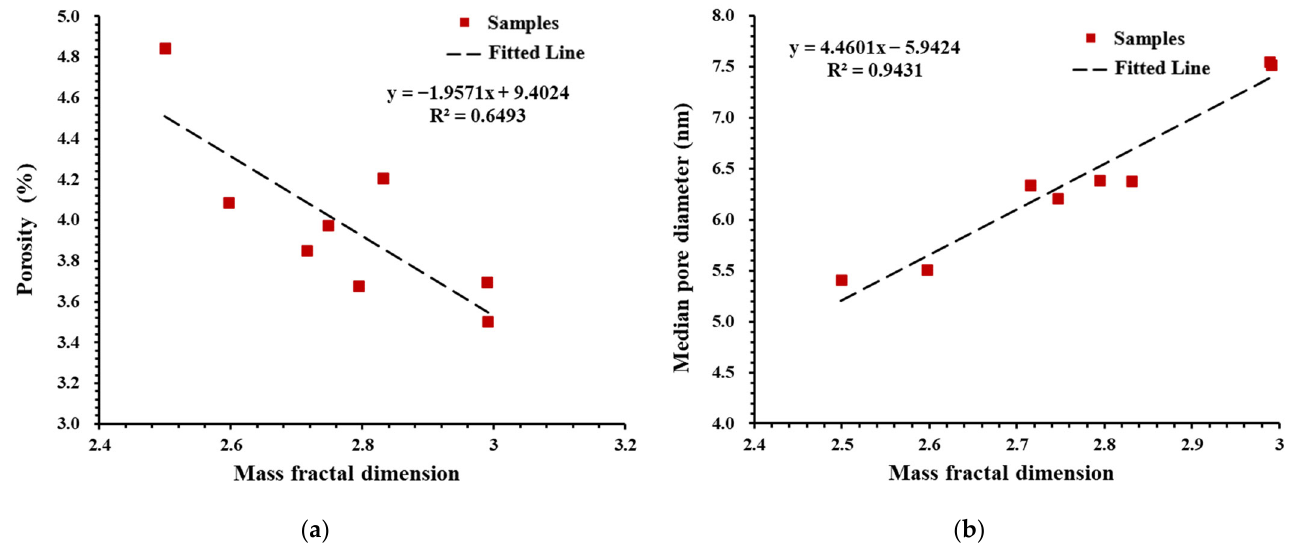
Figure 8. ( a ) Relationship between the mass fractal dimension of deep shale samples and porosity. ( b ) Relationship between the mass fractal dimension and median pore size of deep shale samples.